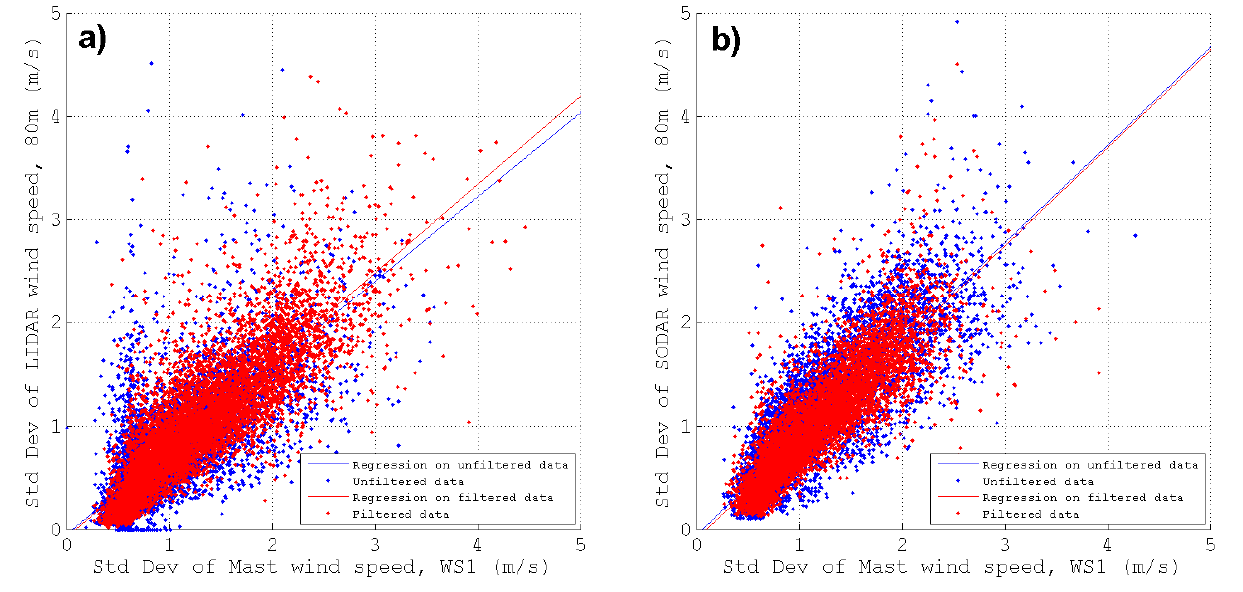
Figure 11. Standard deviation of 80 m wind speed: ( a ) LIDAR, ( b ) SODAR. (February–May; 10 min